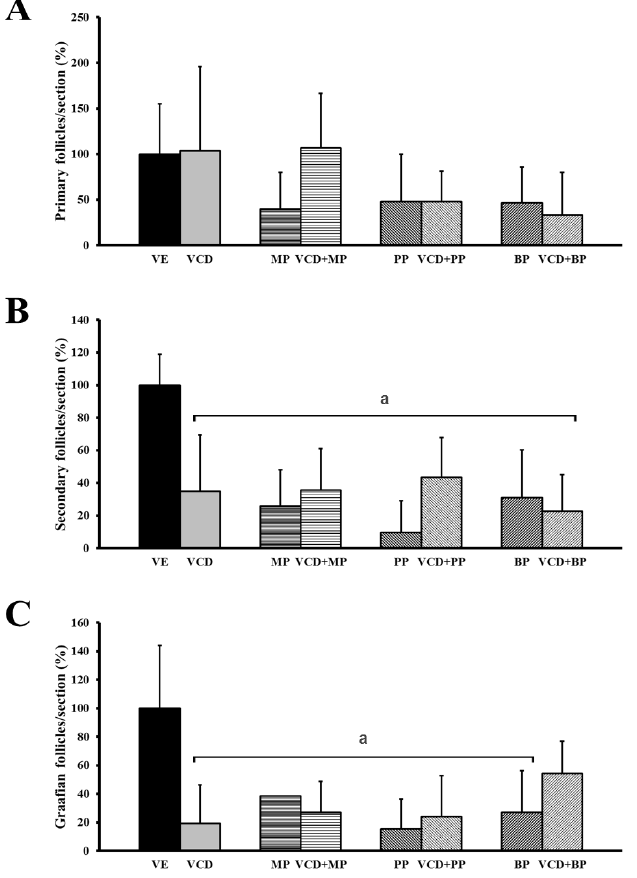
Figure 3. Effects of VCD and parabens on percentage of follicles at each follicle stage. Primary-, secondary- and preovulatory follicles were characterized by the histology of the ovary granulosa cells and oocyte morphology. ( A ) primary follicles; ( B ) Secondary follicles; ( C ) preovulatory follicles. a p < 0.05 vs. VE. Data are presented as the mean ± SD. VE 20% Et-OH, VCD 40 mg/kg/day, MP, PP, BP 100 mg/kg/day.